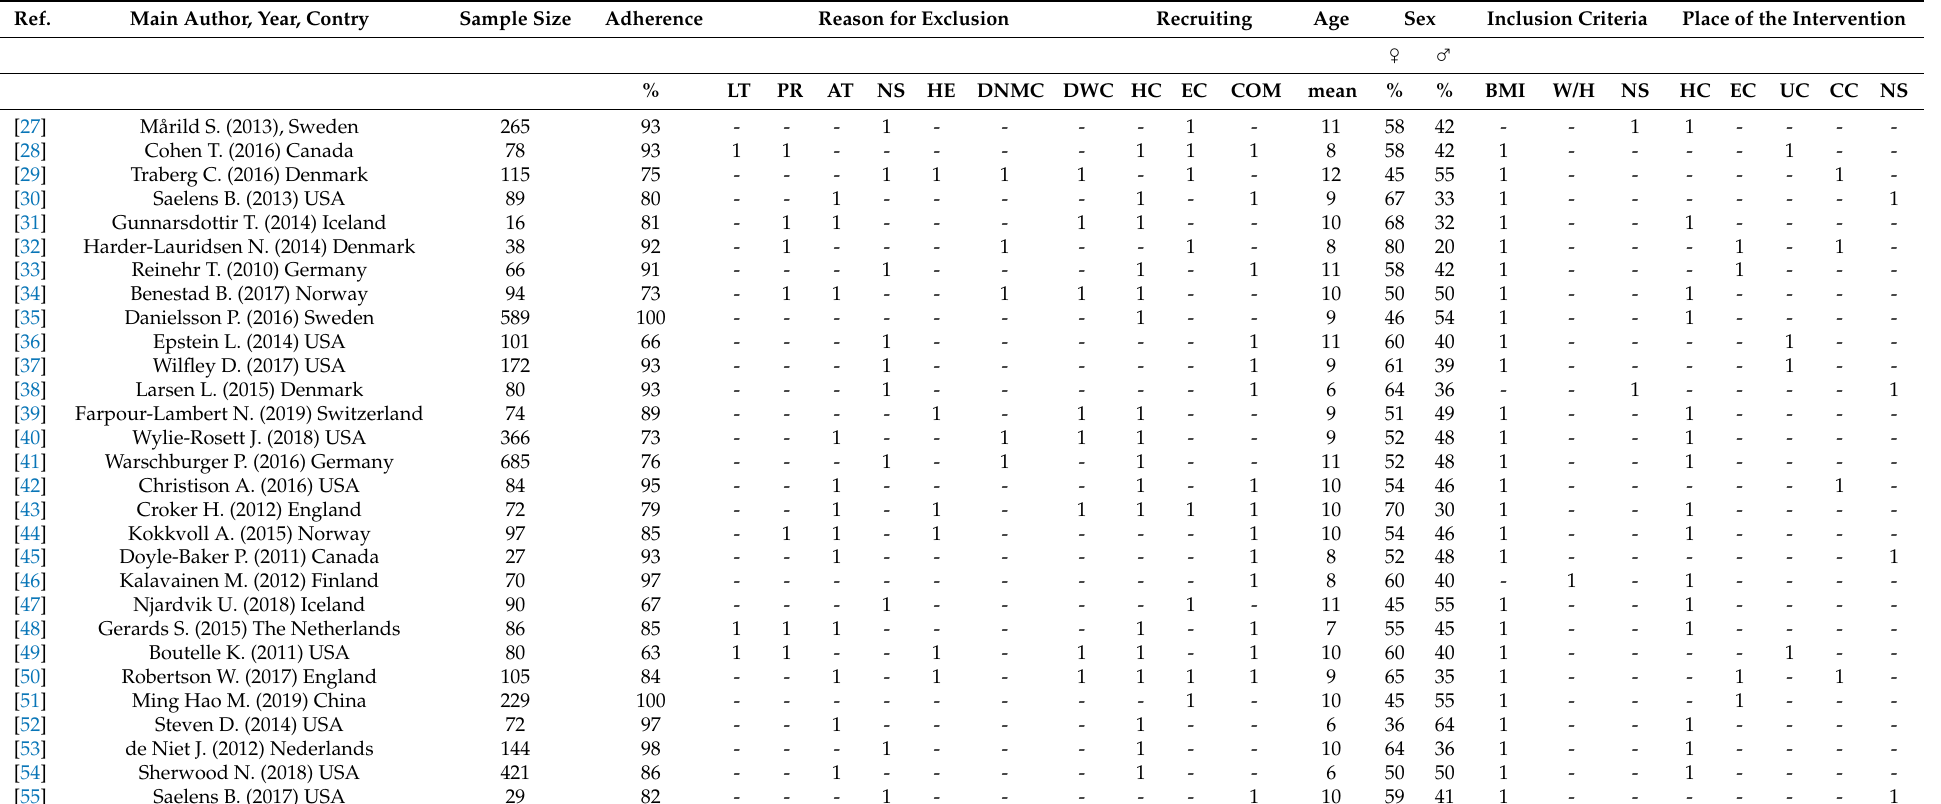
Table 2. Characteristics of the studies analyzed in multicomponent interventions in extremely cold